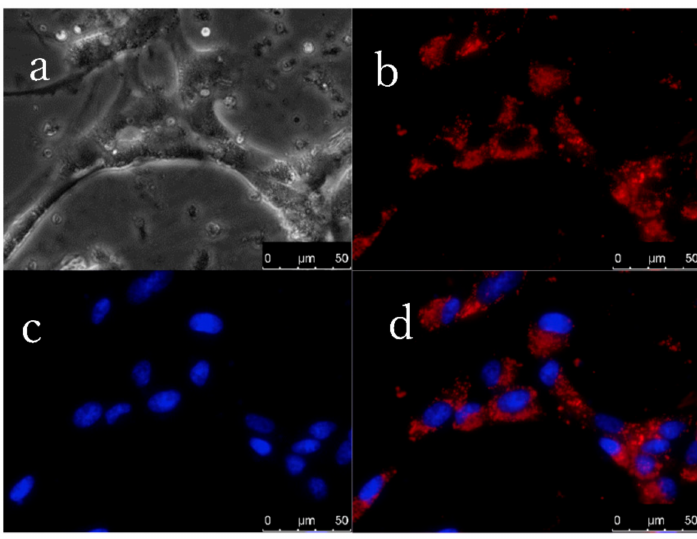
Figure 3. Fluorescence colocalization images of dye 1 and Hoechst 33242 in live bovine cumulus cells. ( a ) bright field; ( b ) cellular uptake of dye 1 in the cytoplasm, TX2 filters (BP 560/40, BP 645/75); ( c ) Hoechst stained nuclei region, DAPI filters (BP 350/50, BP 460/50); ( d ) overlay of b/c.